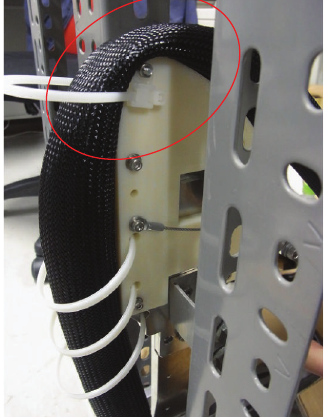
Figure 16: Flattened tube at deep flexion of the